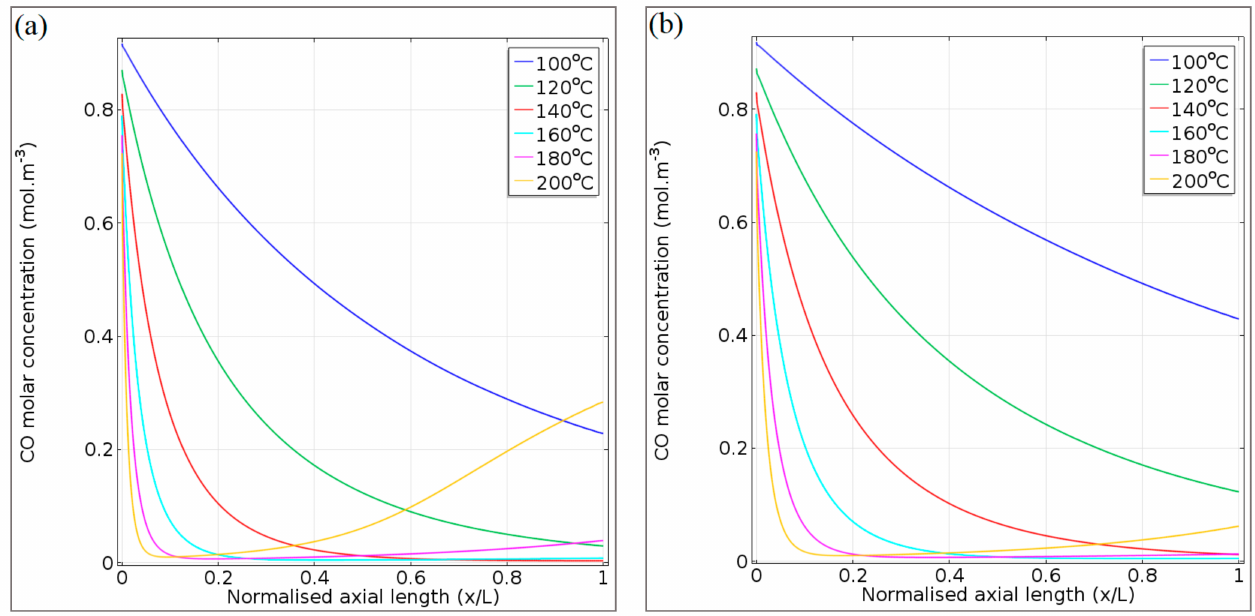
Figure 11. CO concentration profiles for ( a ) 65.2 NL g cat − 1 h − 1 and ( b ) 130.4 NL g cat − 1 h − 1 , at 100–200 ◦